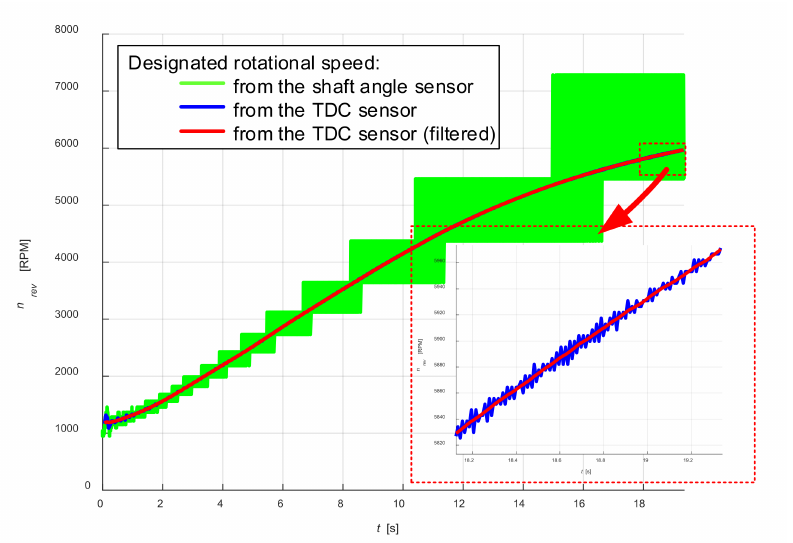
Figure 3. Example diagrams of rotational speed changes determined on the basis of signals from the sensor of the top dead center of the piston and the sensor of the crankshaft